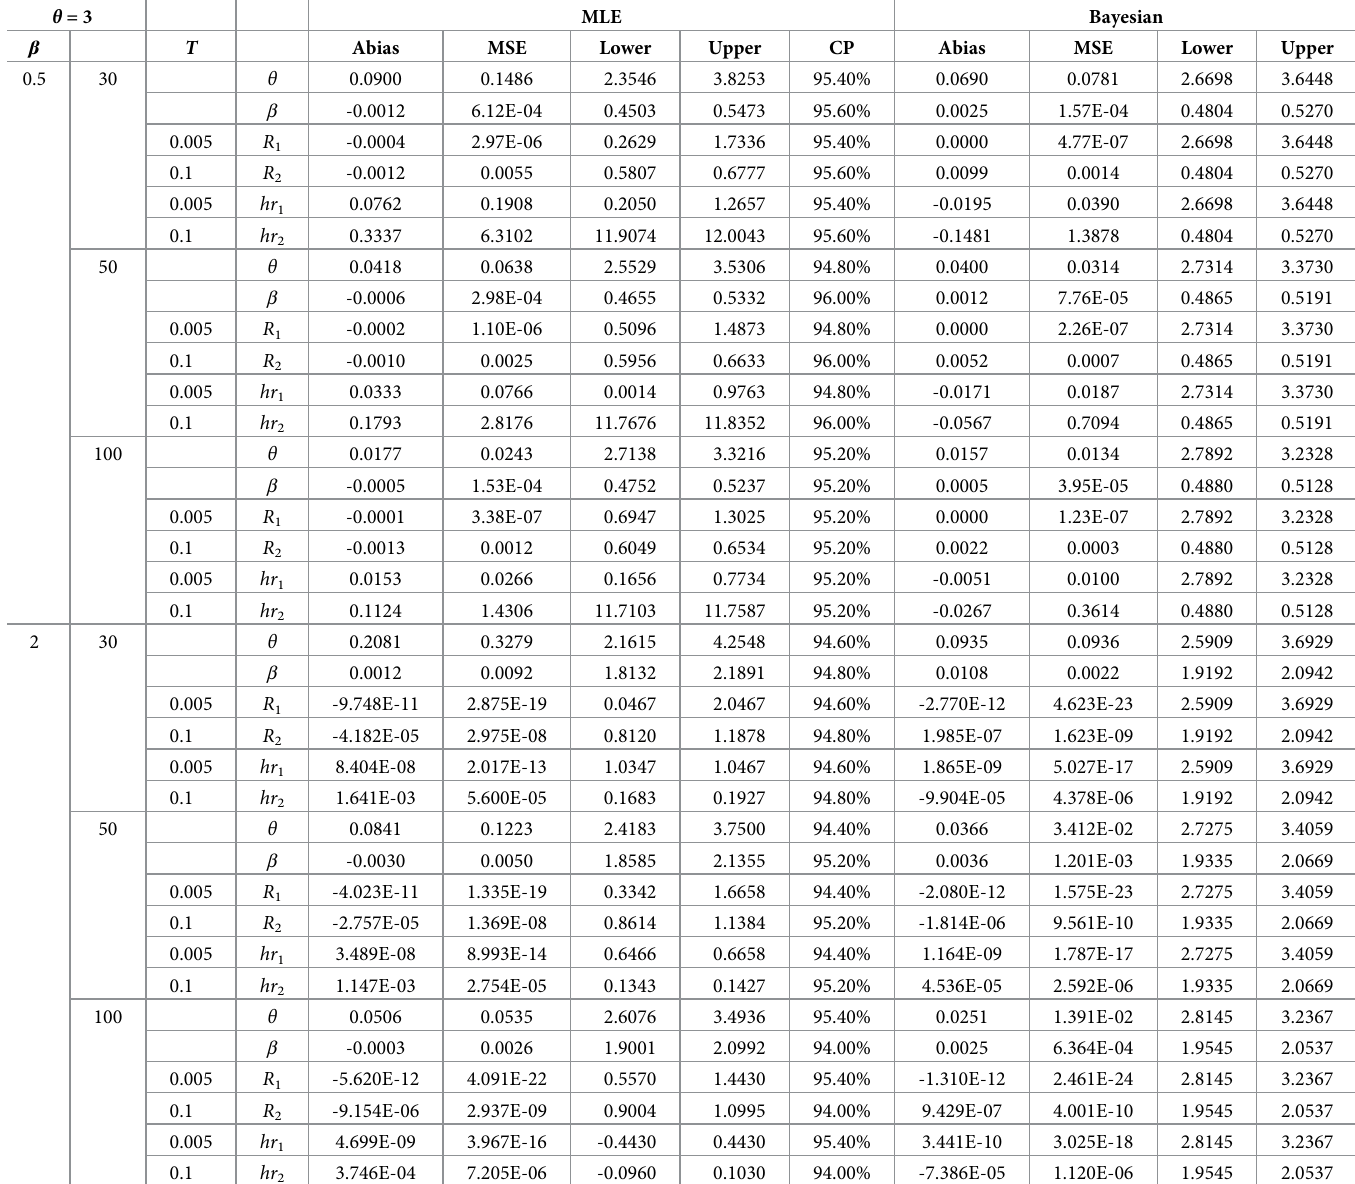
Table 1. Simulation results when the value of θ =